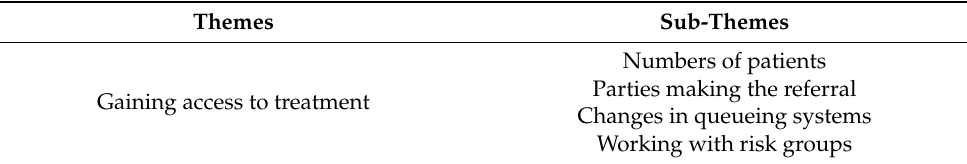
Table 1. Themes of the